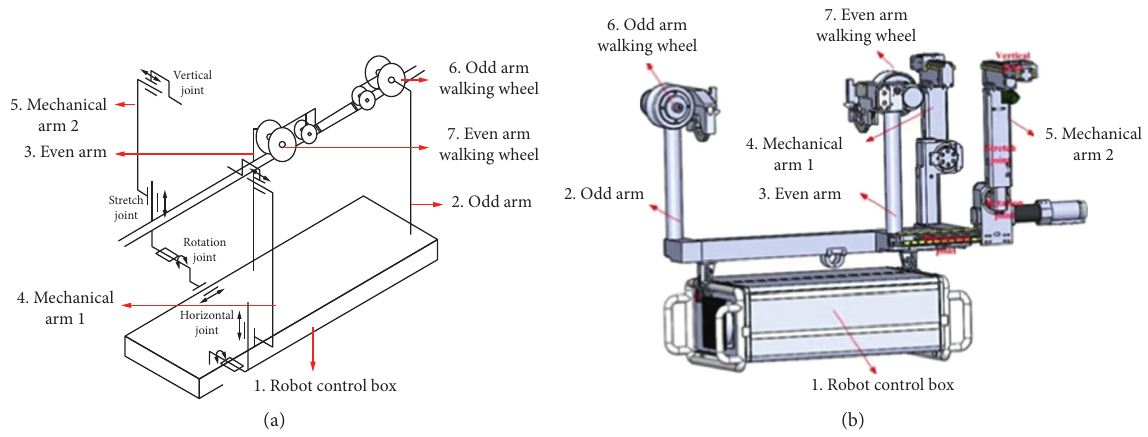
Figure 1: Configuration and entity model of live maintenance robot mobile platform. (a) Configuration. (b) Entity model.